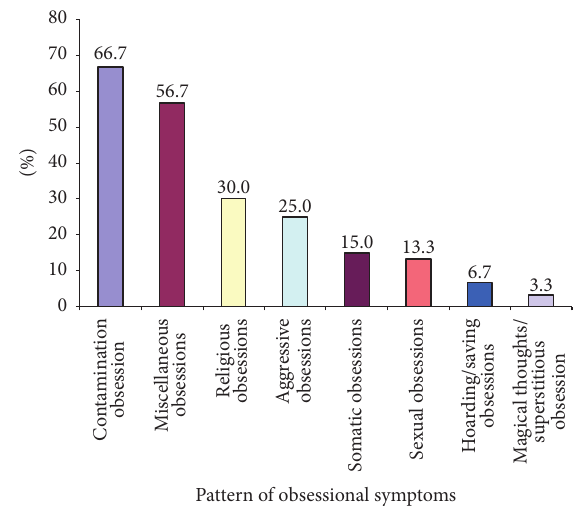
Figure 1: Pattern of obsessive symptoms among 8–18-year-old respondents ( 𝑛 = 60